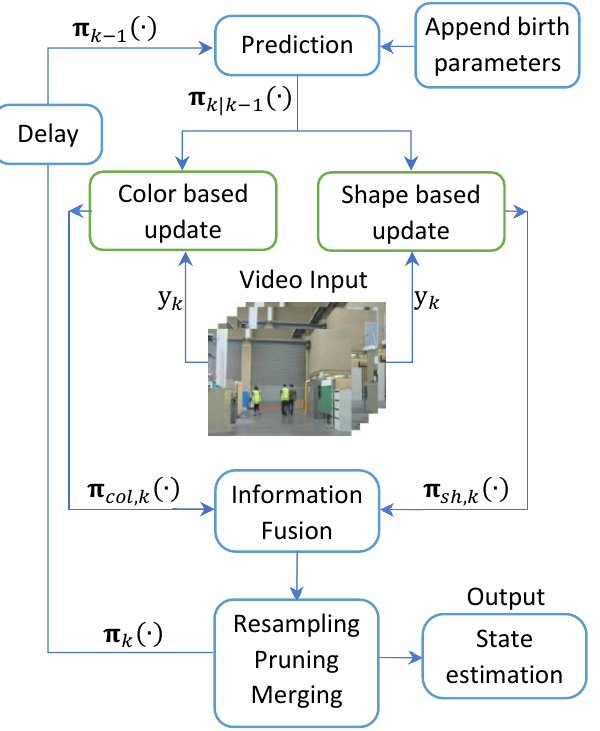
Figure 2. Overall diagram of the proposed